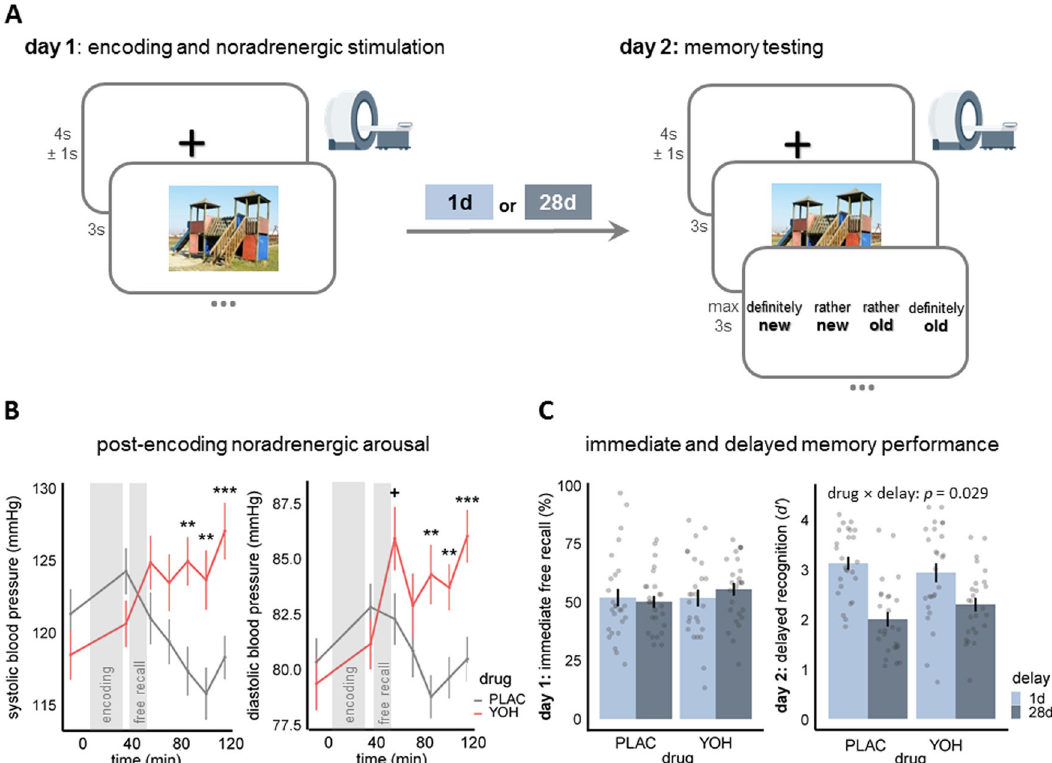
Fig. 1 Experimental design, physiological, and behavioral results. A Participants were tested on two experimental days: day 1, stimulus encoding and pharmacological manipulation of post-encoding noradrenergic activity and day 2, memory recognition. Both encoding and test took place in the MRI scanner. Critically, to investigate time-dependent consolidation processes, the memory test took place either 1d or 28d after encoding. The image of the playground is licensed under Creative Commons License; courtesy of Tomasz Sienicki (https://commons.wikimedia.org/wiki/File:Playground_29_ubt.JPG; image unchanged). B Effective manipulation of noradrenergic arousal after encoding: While groups did not differ at baseline (all p > 0.242, two-tailed Welch ’ s t -tests) or shortly after encoding (all p > 0.111, two-tailed Welch ’ s t- tests), participants of the yohimbine (YOH) group had signi fi cantly higher systolic (all p < 0.005, two-tailed Welch ’ s t- tests) and diastolic (all p < 0.005, two-tailed Welch ’ s t- tests) blood pressure from 85 min after drug intake until the end of experimental day 1 (drug × time: all p < 0.001, mixed ANOVAs). C A generalized linear mixed model (LMM) with the between-factors drug and delay and the within-factor emotion revealed no group-difference in immediate free recall performance on day 1, suggesting that encoding was comparable in the four groups. However, while memory performance signi fi cantly decreased from 1d to 28d after encoding (main effect delay: β = − 1.12, p < 0.001, LMM), post-encoding noradrenergic arousal reduced this time-dependent memory decline (drug × delay: β = 0.64, p = 0.029, LMM): The YOH group showed a signi fi cantly smaller decrease in memory performance from 1d to 28d than the placebo (PLAC) group. All n = 104 participants. Bars represent mean ± SEM. Source data are provided as Source data fi le. ** p < 0.010; *** p <